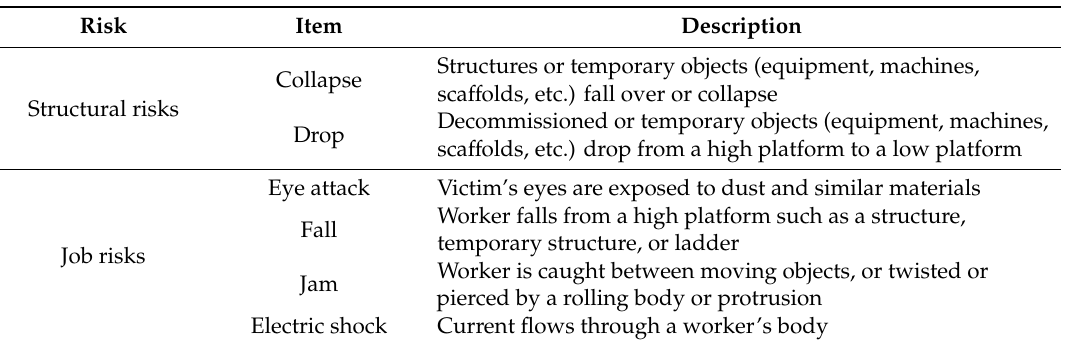
Table 3. Structural and job risks associated with decommissioning a bio-shield